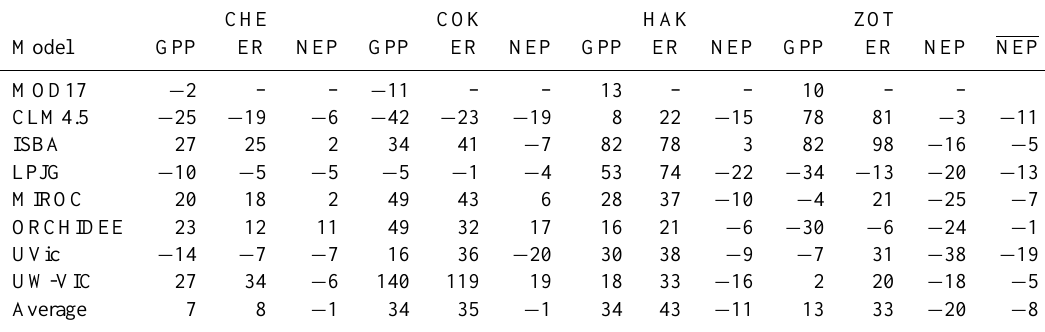
Table 4. Average model error in gCm − 2 month − 1 for site-level comparisons over the years 2002–2005 shown in Figs. 2–4. Errors are calculated as the average ( ˆ (cid:15) j ) over all years and months for which a model estimate and site estimate are available at a given site. Thus, for each site and month, the mean bias error (MBE) is calculated as the average difference between the model and observed values: (cid:15) j = C j − C obs , where C j is GPP, ER or NEP for model j and C obs is the observed value from the La Thuile FLUXNET observations (Baldocchi, 2008). The last column lists mean NEP error (NEP) across all sites. Model estimates for years 2002–2005 are not available for CoLM and JULES. Differences were evaluated using a 2-way repeated measures ANOVA test. Test design was a comparison of GPP vs ER t tests